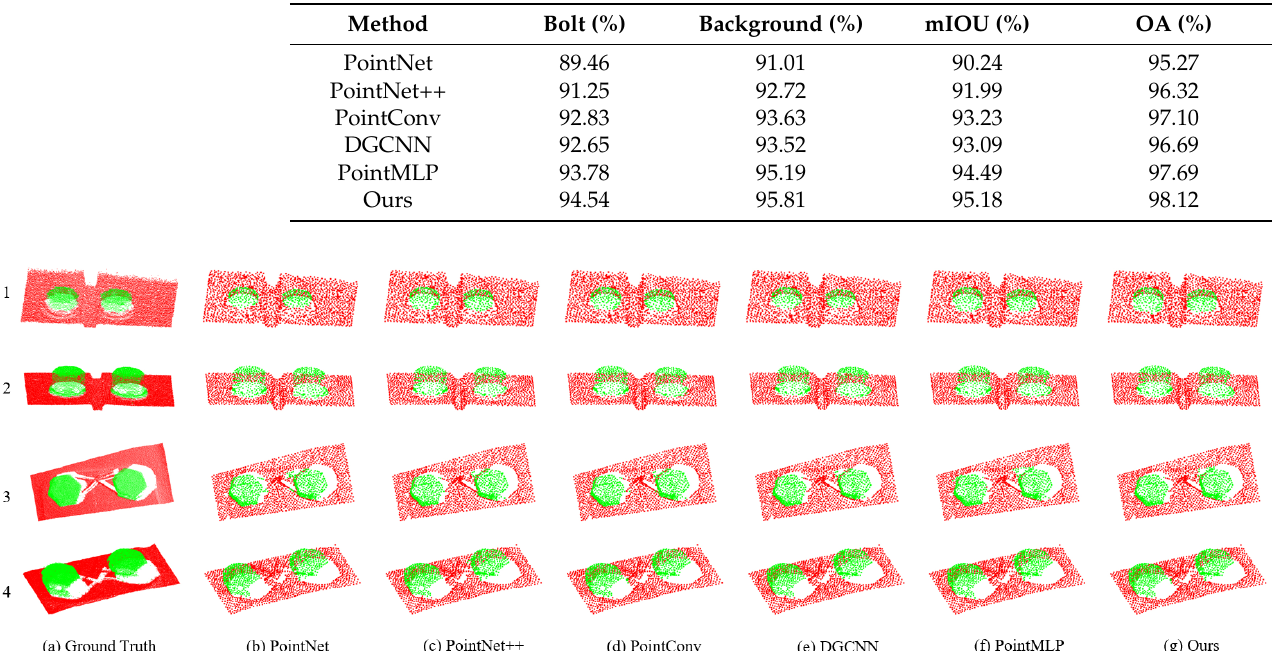
Table 6. Comparison of segmentation results.